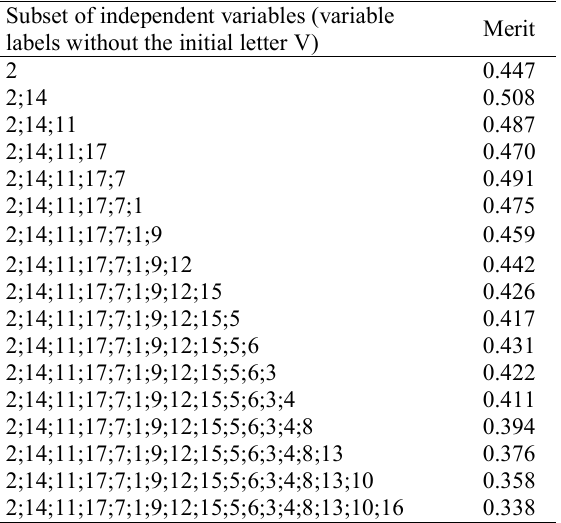
Table 3. Merit values for each subset of variables on the P-J motorway section.